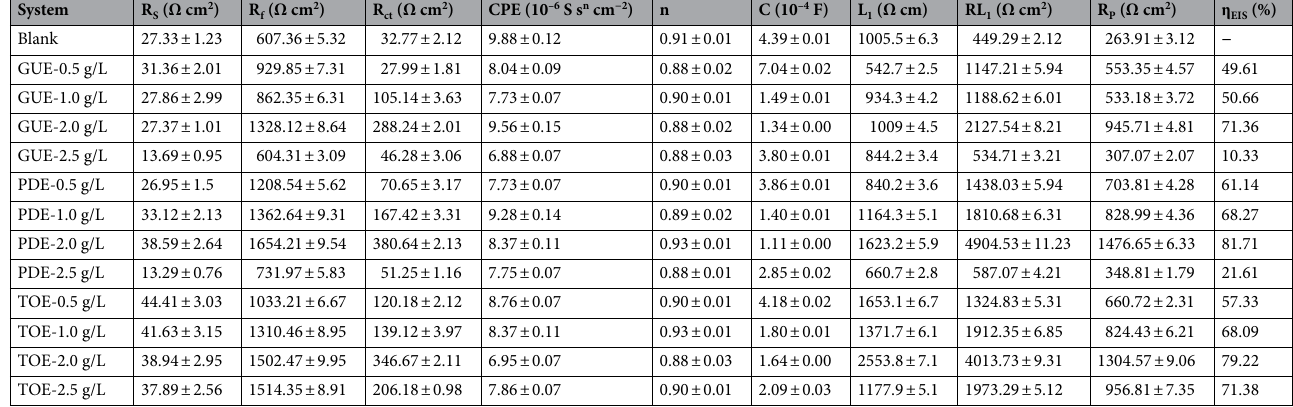
Table 3. Corresponding fitted parameters of PDP curves and EIS spectra of AZ91 Mg alloy in 3.5 wt% NaCl solution without and with different concentrations of GUE, PDE, TOE at normal temperature.